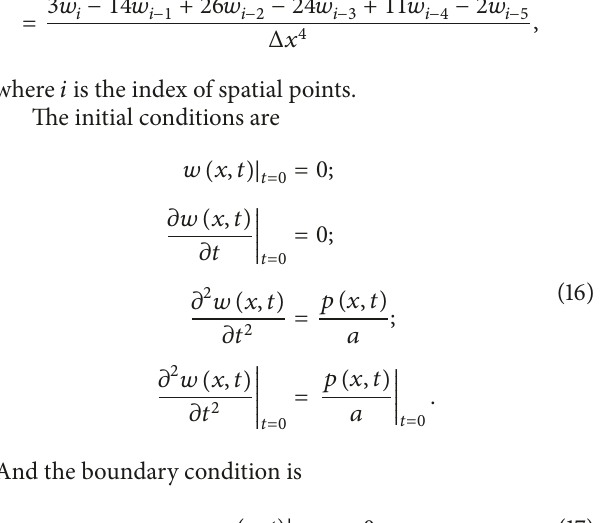
Figure 2: Radial displacement of the shell at varied times (dt = 0.2 msec, the curves correspond to 2 msec, 10msec, 20msec, and 40